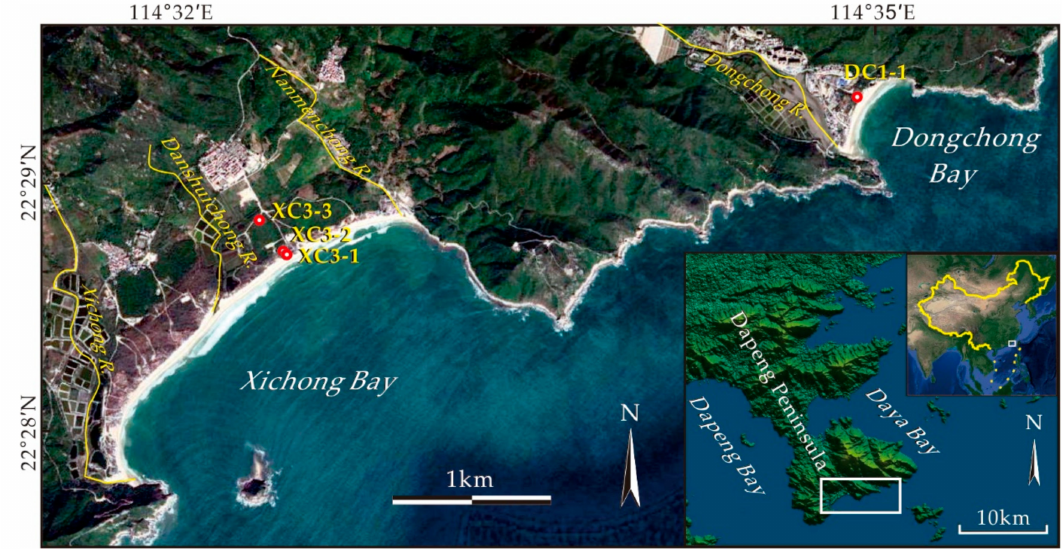
Figure 1. Map of study area. Red circles are the locations of cores at Dongchong and